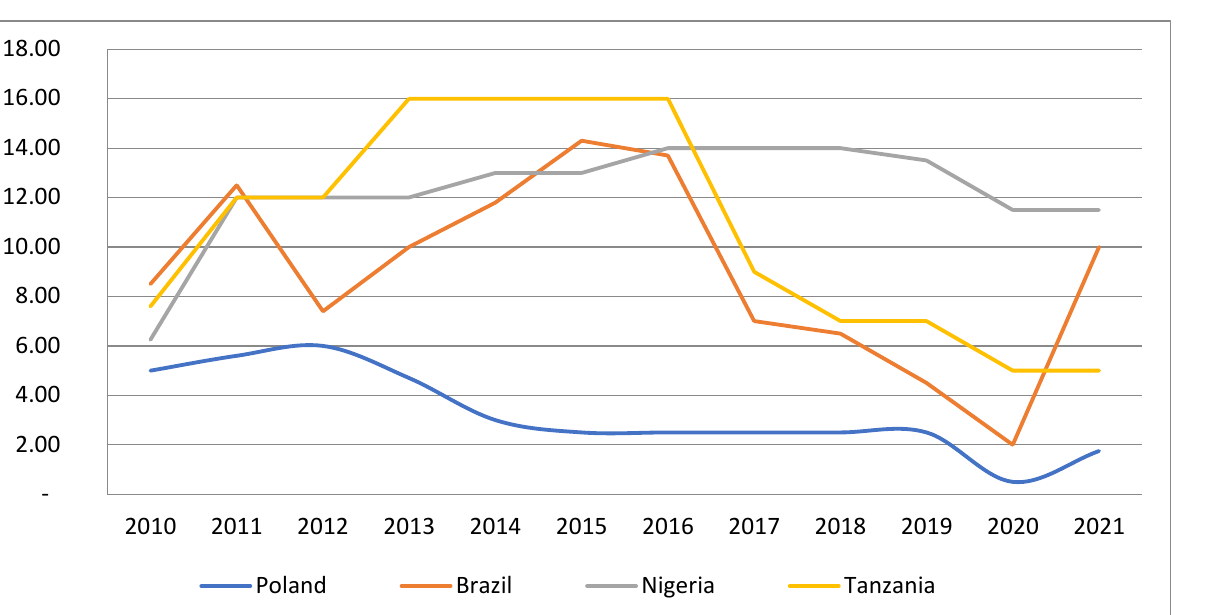
Figure 6. Changes in the base rate (%) in the years 2010 – 2021. Source [78 – 85].